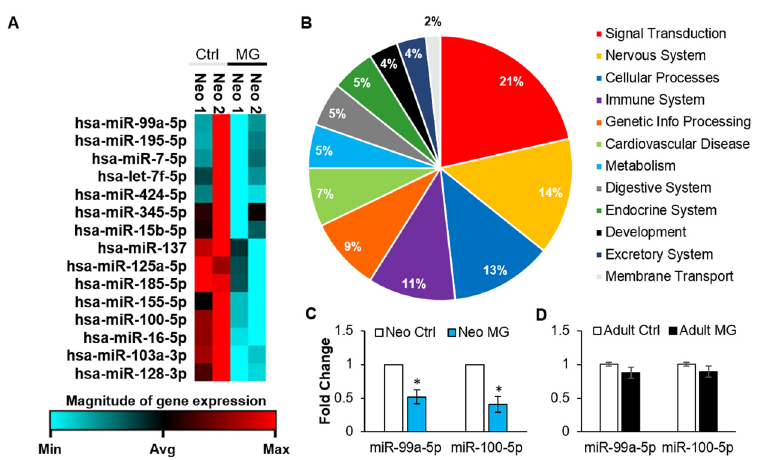
Fig 4. MicroRNA expression changes in neonatal CPCs after 6 – 7 days of simulated microgravity. A) Heat map of 15 microRNAs that were significantly altered in neonatal CPCs after simulated microgravity. Two representative neonatal CPC clones are shown above. Red color identifies maximum expression, black color represents average expression, blue color identifies microRNAs with minimum expression. Sets of co- regulated microRNAs were grouped together by RT 2 Profiler PCR Array Data Analysis software (SABiosciences). B) MicroRNAs expressed at significantly different levels during simulated microgravity were analyzed using DIANA mirPATH software. Pathways significantly regulated by altered microRNAs were grouped according to KEGG pathway classifications, and the percentage of pathways in each category is displayed above. C) MicroRNA-100-5p and miR-99a-5p whose expression levels negatively correlate with stemness, were significantly downregulated after 6 – 7 days of simulated microgravity in neonatal CPCs (n = 3, p < 0.05). D) Expression of microRNA-99a-5p and miR-100-5p were unchanged in adult CPCs after simulated microgravity (n = 3, run in